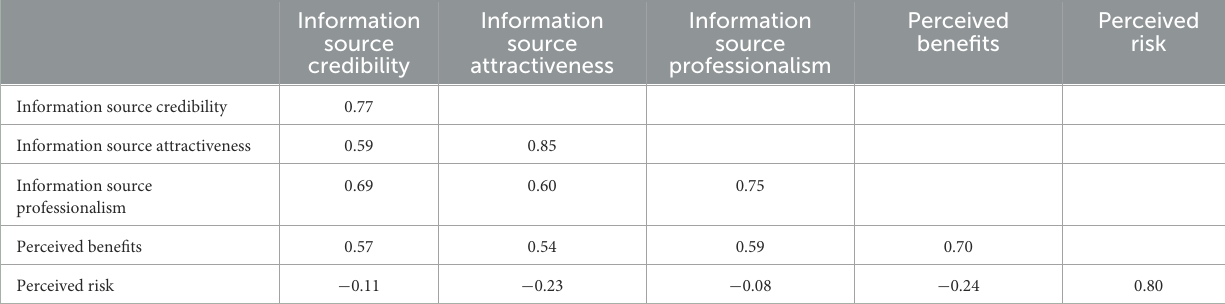
TABLE 3 Discriminant validity: Pearson correlation and AVE square root